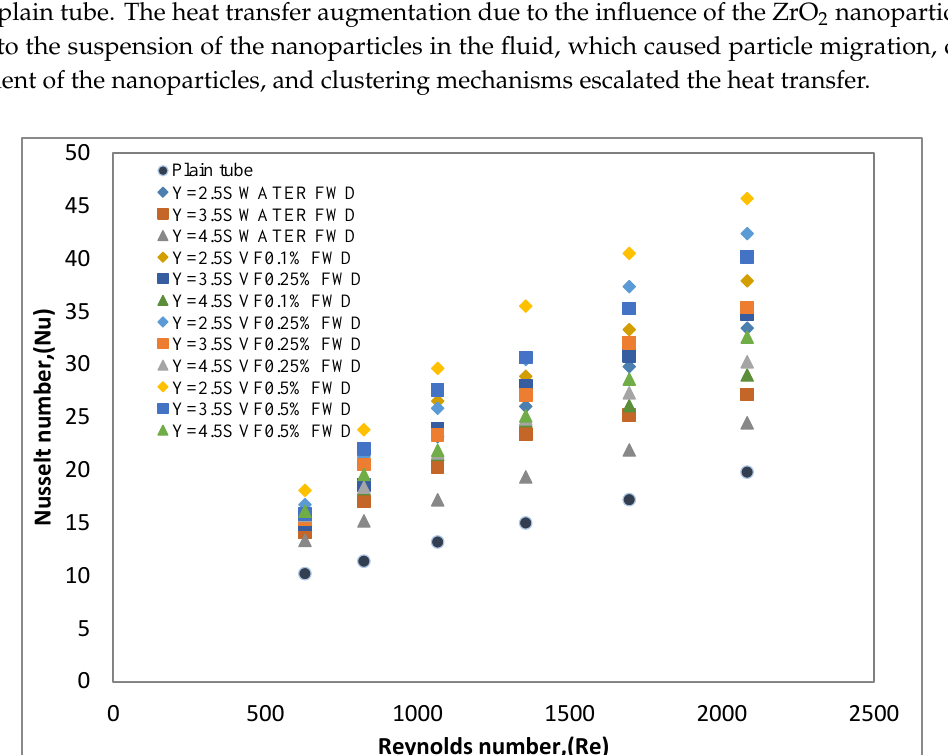
Figure 11. Nusselt number versus Reynolds number for the staggered conical strip insert with a backward arrangement using deionized water and ZrO 2 /deionized water nanofluidsunder laminar flow conditions.